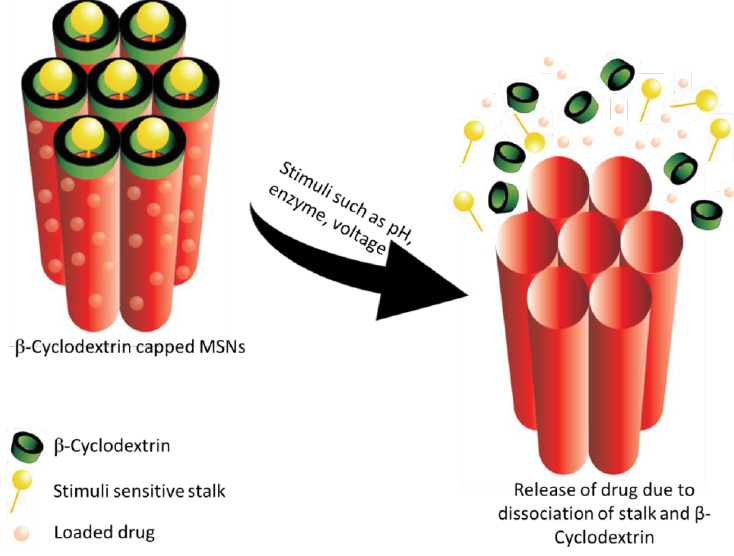
Figure 4. Schematic illustration of the release of drug from β-CD capped MSNs in response to